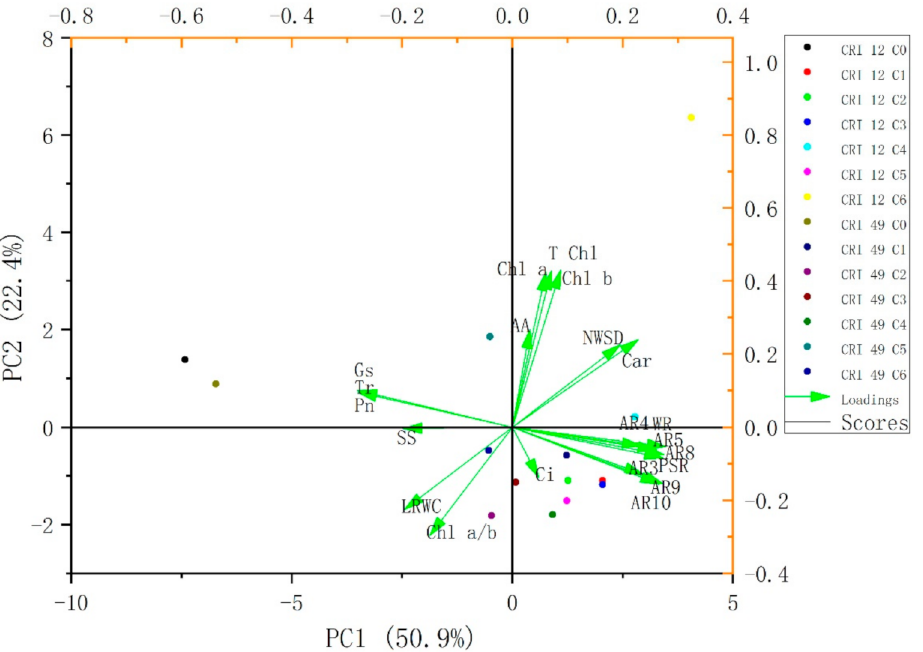
Figure 1. Cluster analysis of different concentration thidiazuron (TDZ) treatment in CRI 49 and CRI 12.